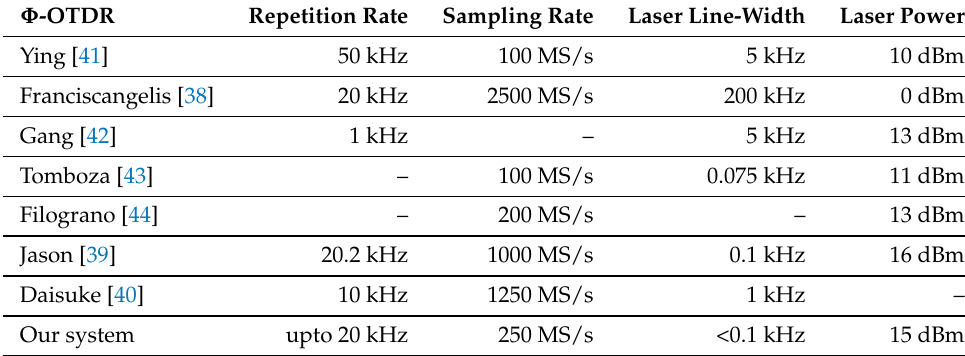
Table 1. Comparison of the Φ -OTDR system.